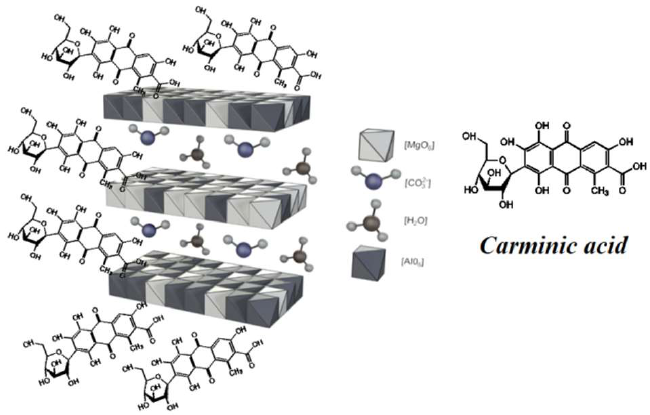
Figure 7. Proposed arrangement of carminic acid molecules in LH pigments.